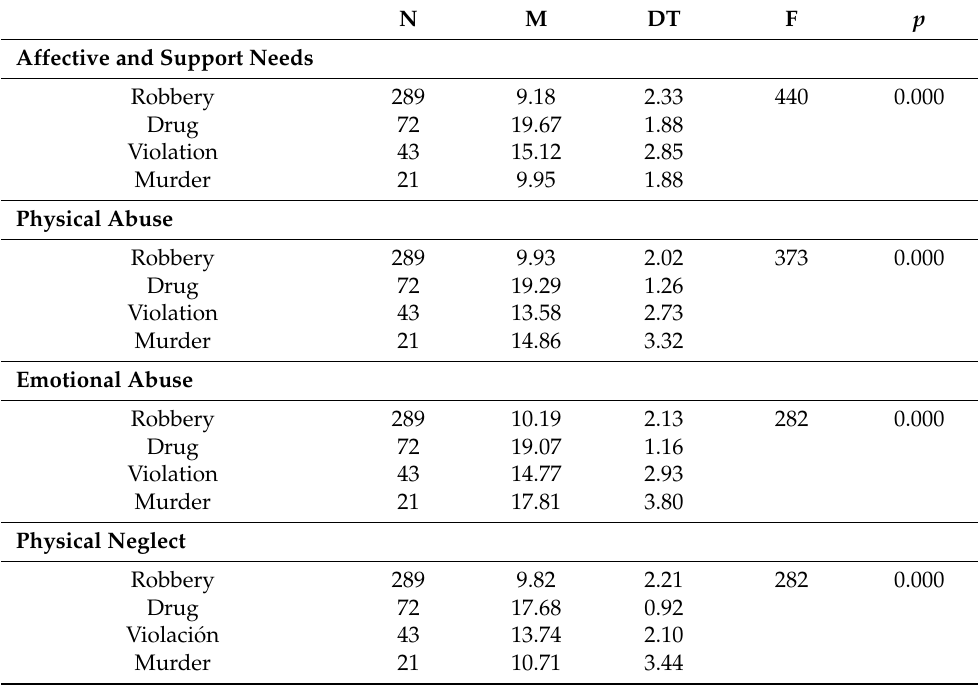
Table 10. Mean differences in the type of abuse for the committed crime factor (robbery, drug, rape, murder). N M DT F p Affective and Support